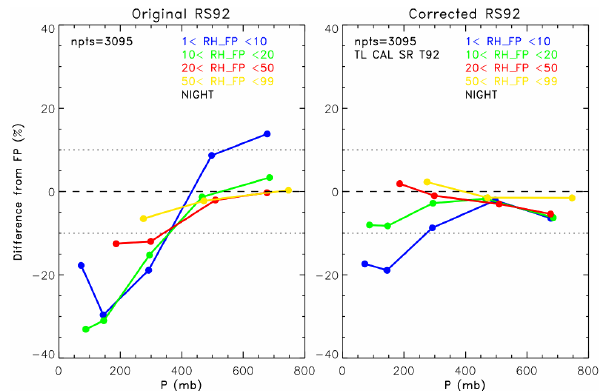
Fig. 9. RS92 mean bias relative to frostpoint hygrometer for the MOHAVE 2009 nighttime dual soundings, Fig. A4. RS92 mean bias relative to frost point hygrometer for the shown as a function of pressure ( P ) in 4 RH intervals, for the original RS92 measurements (left) and after MOHAVE 2009 nighttime dual soundings, shown as a function of applyingthecalibrationandtime-lagcorrections(right). pressure ( P ) in 4RH intervals, for the original RS92 measurements (left panel) and after applying the calibration and time-lag correc- tions (right panel).